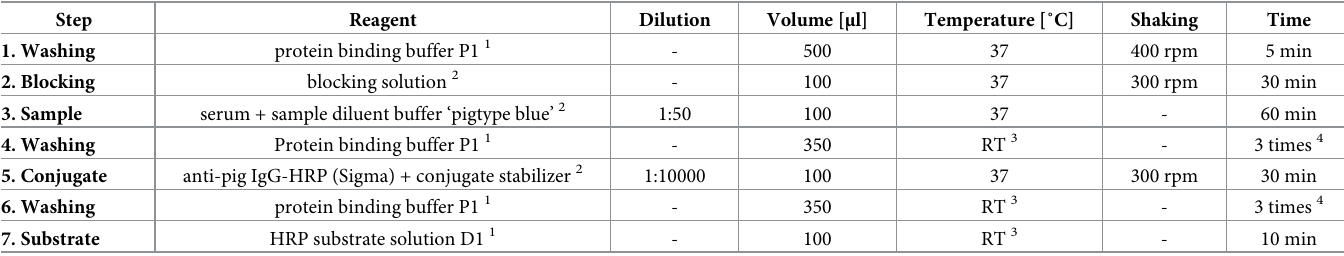
Table 2. Test protocol for microarray analysis.